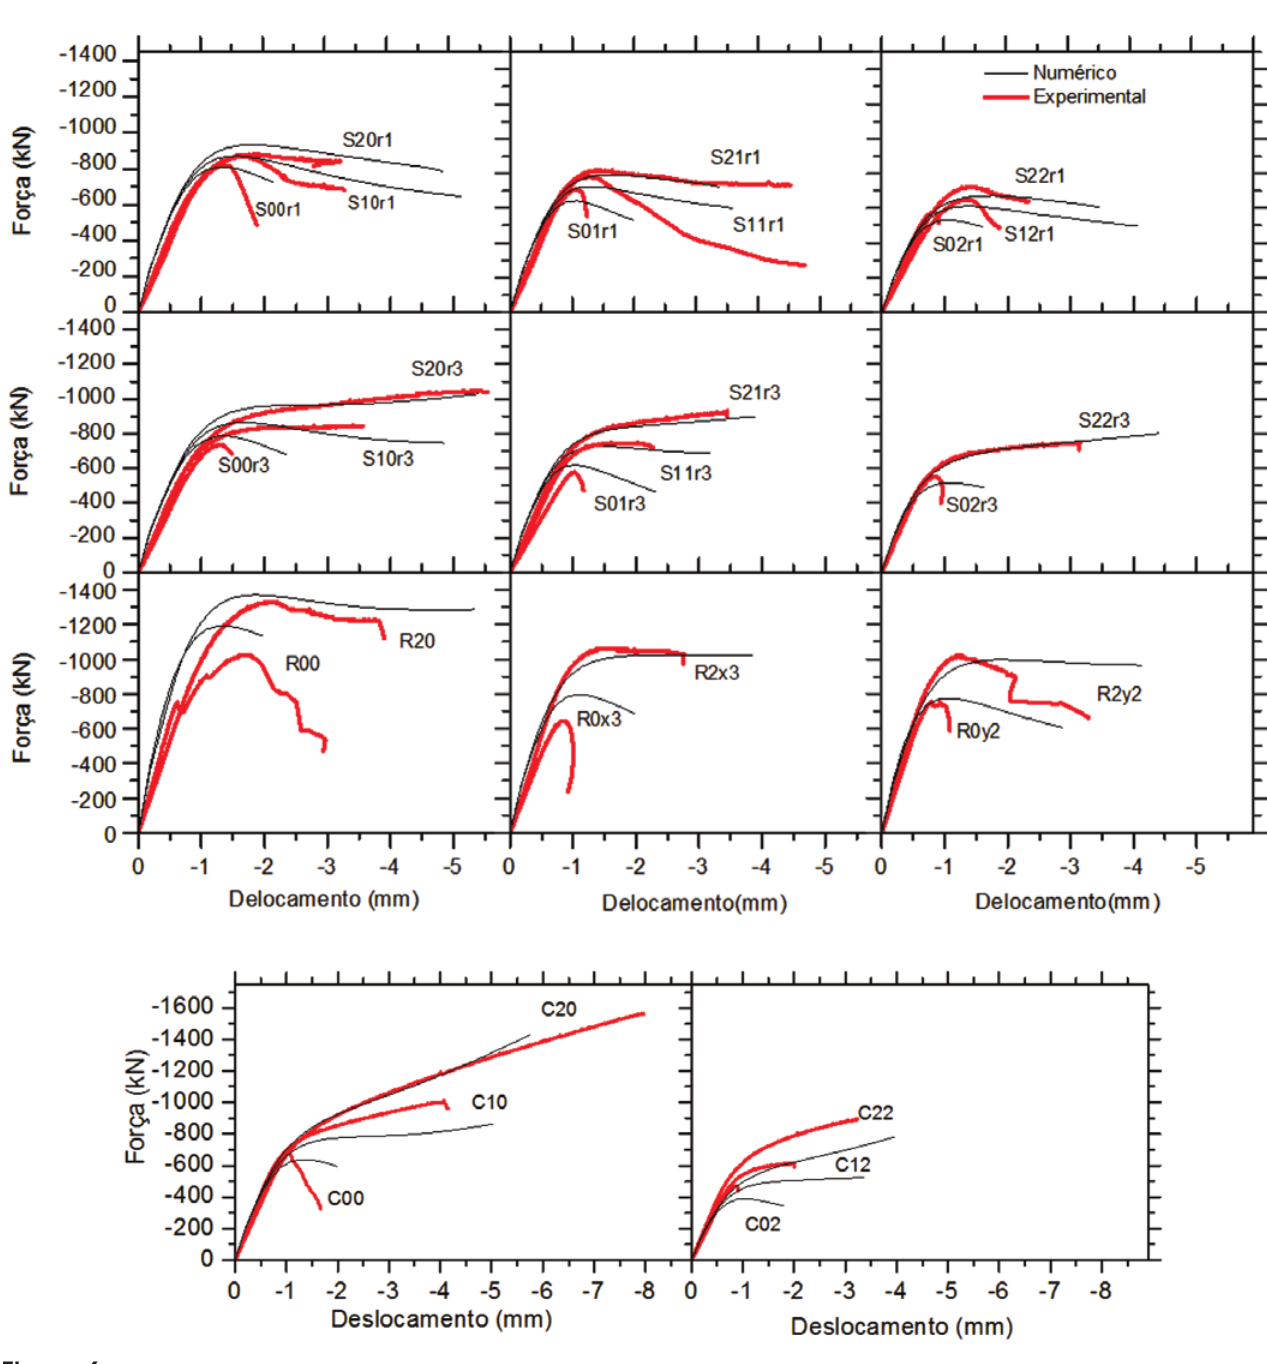
Comparação entre curvas de força versus deslocamento obtidas na modelagem numérica em relação às obtidas nos ensaios experimentais por Carrazedo [17], para pilares das séries de 1 a